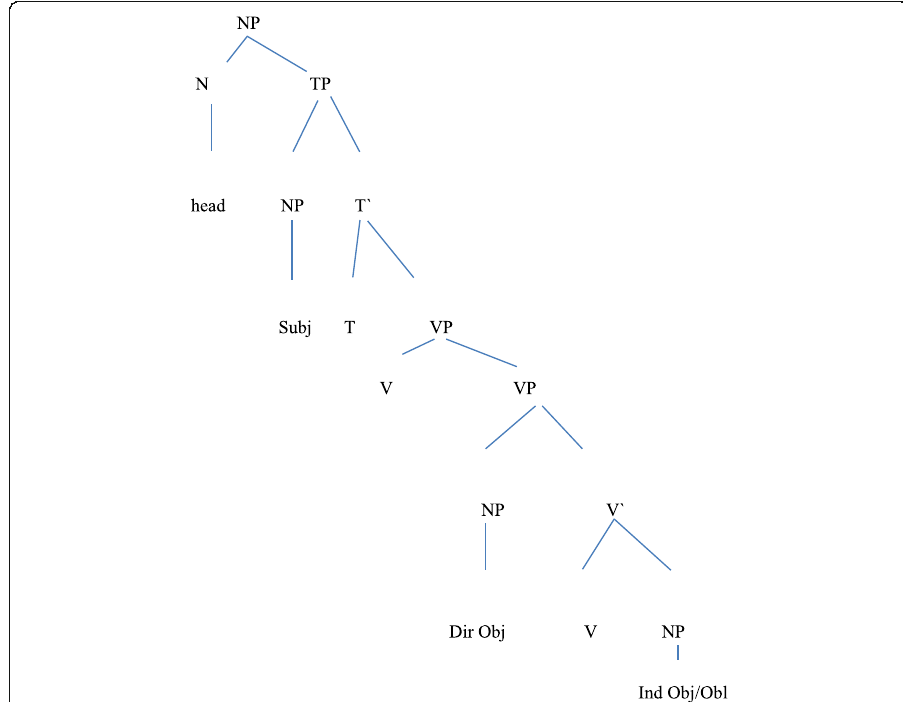
Fig. 2 A minimalistic view of asymmetries in the position of arguments within RC ’ s. As Fig. 2 shows a minimalistic view further verifies the higher position of subjects compared to direct objects and direct objects compared to indirect